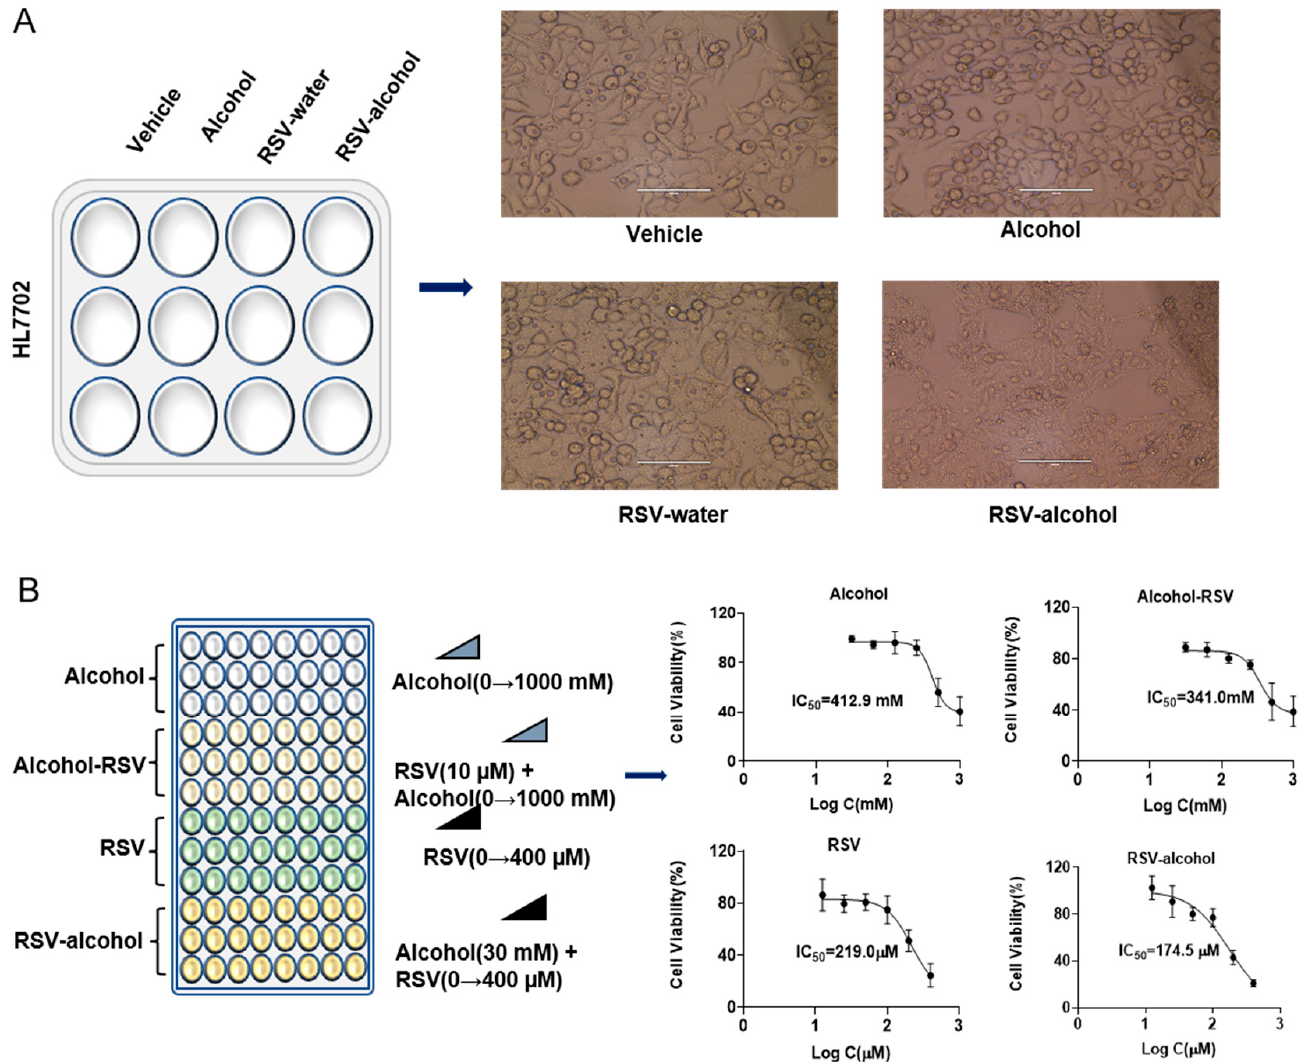
Figure 2. The RSV-alcohol combination worsened ALD in mice and reduced the efficacy of RSV. ( A ) RSV-alcohol combination affected the morphology of HL7702 cells. ( B ) The combination reduced the IC50s of alcohol and RSV compared with use